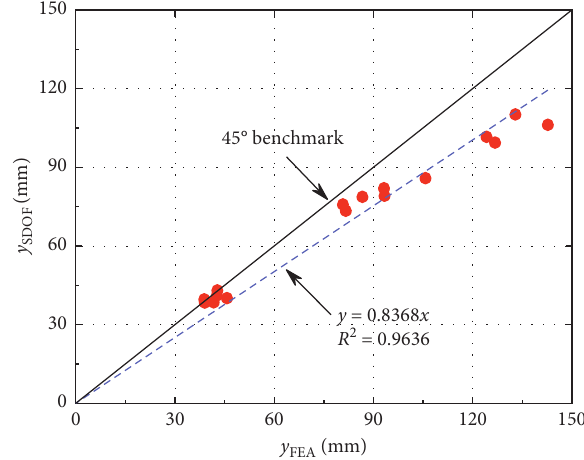
Figure 11: Accuracy analysis of the proposed calculation